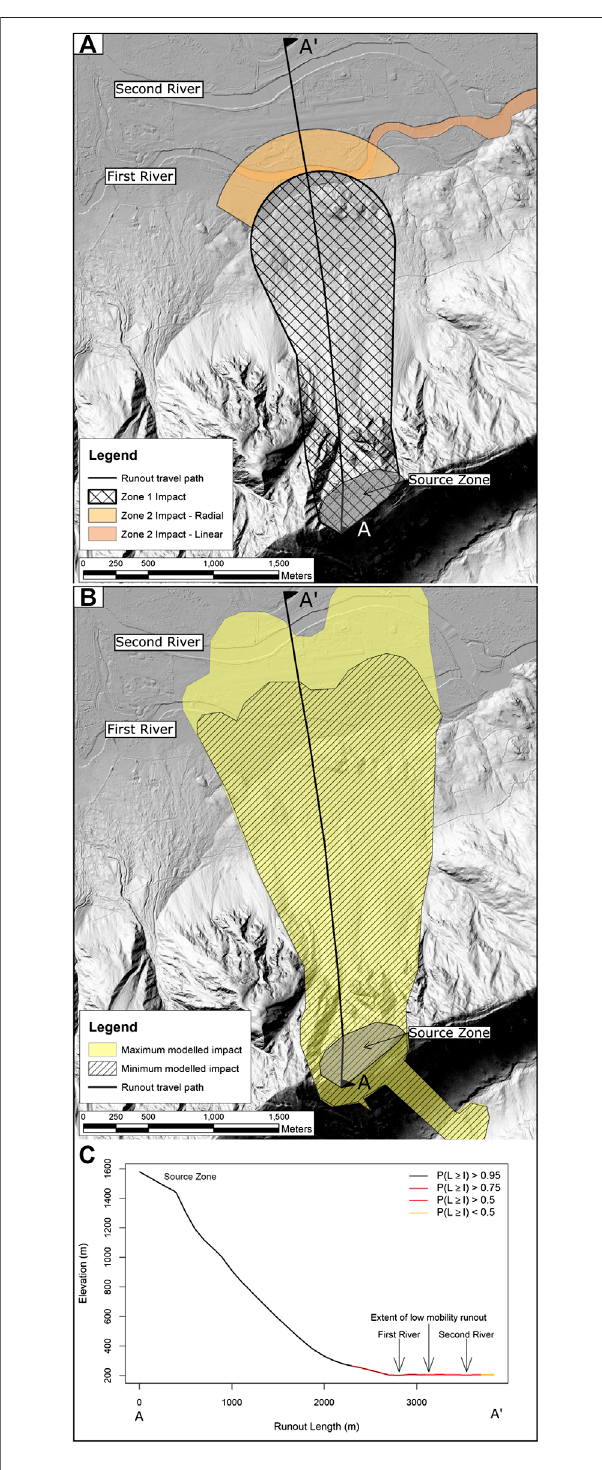
FIGURE 11 | (A) Interpreted Zone 1 and Zone 2 impact areas, with alternative Zone 2 impact areas considering radial or linear cases. (B) Topographyofpotentialrockavalanche areawiththemaximumandminimum mobilitycasesfromnumericalmodeling(Mitchelletal.,2018)and (C) the runout pro fi leused fortheempirical analysis,showingtheprobabilityofrunout exceedance results along the travel